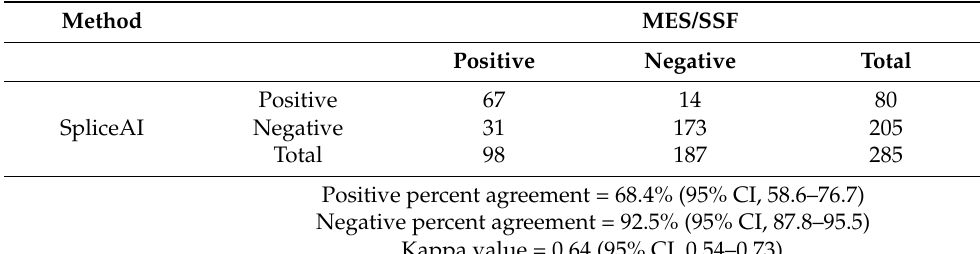
Table 3. Agreement analysis of SpliceAI and MES/SSF for predicting NF1 splice effect.